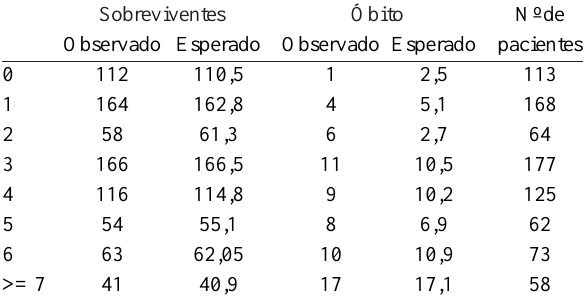
Tabela 8. Mortalidade observada e prevista usando o EuroSCORE como variável preditora nos grupos definidos pelo teste Hosmer-Lemeshow.